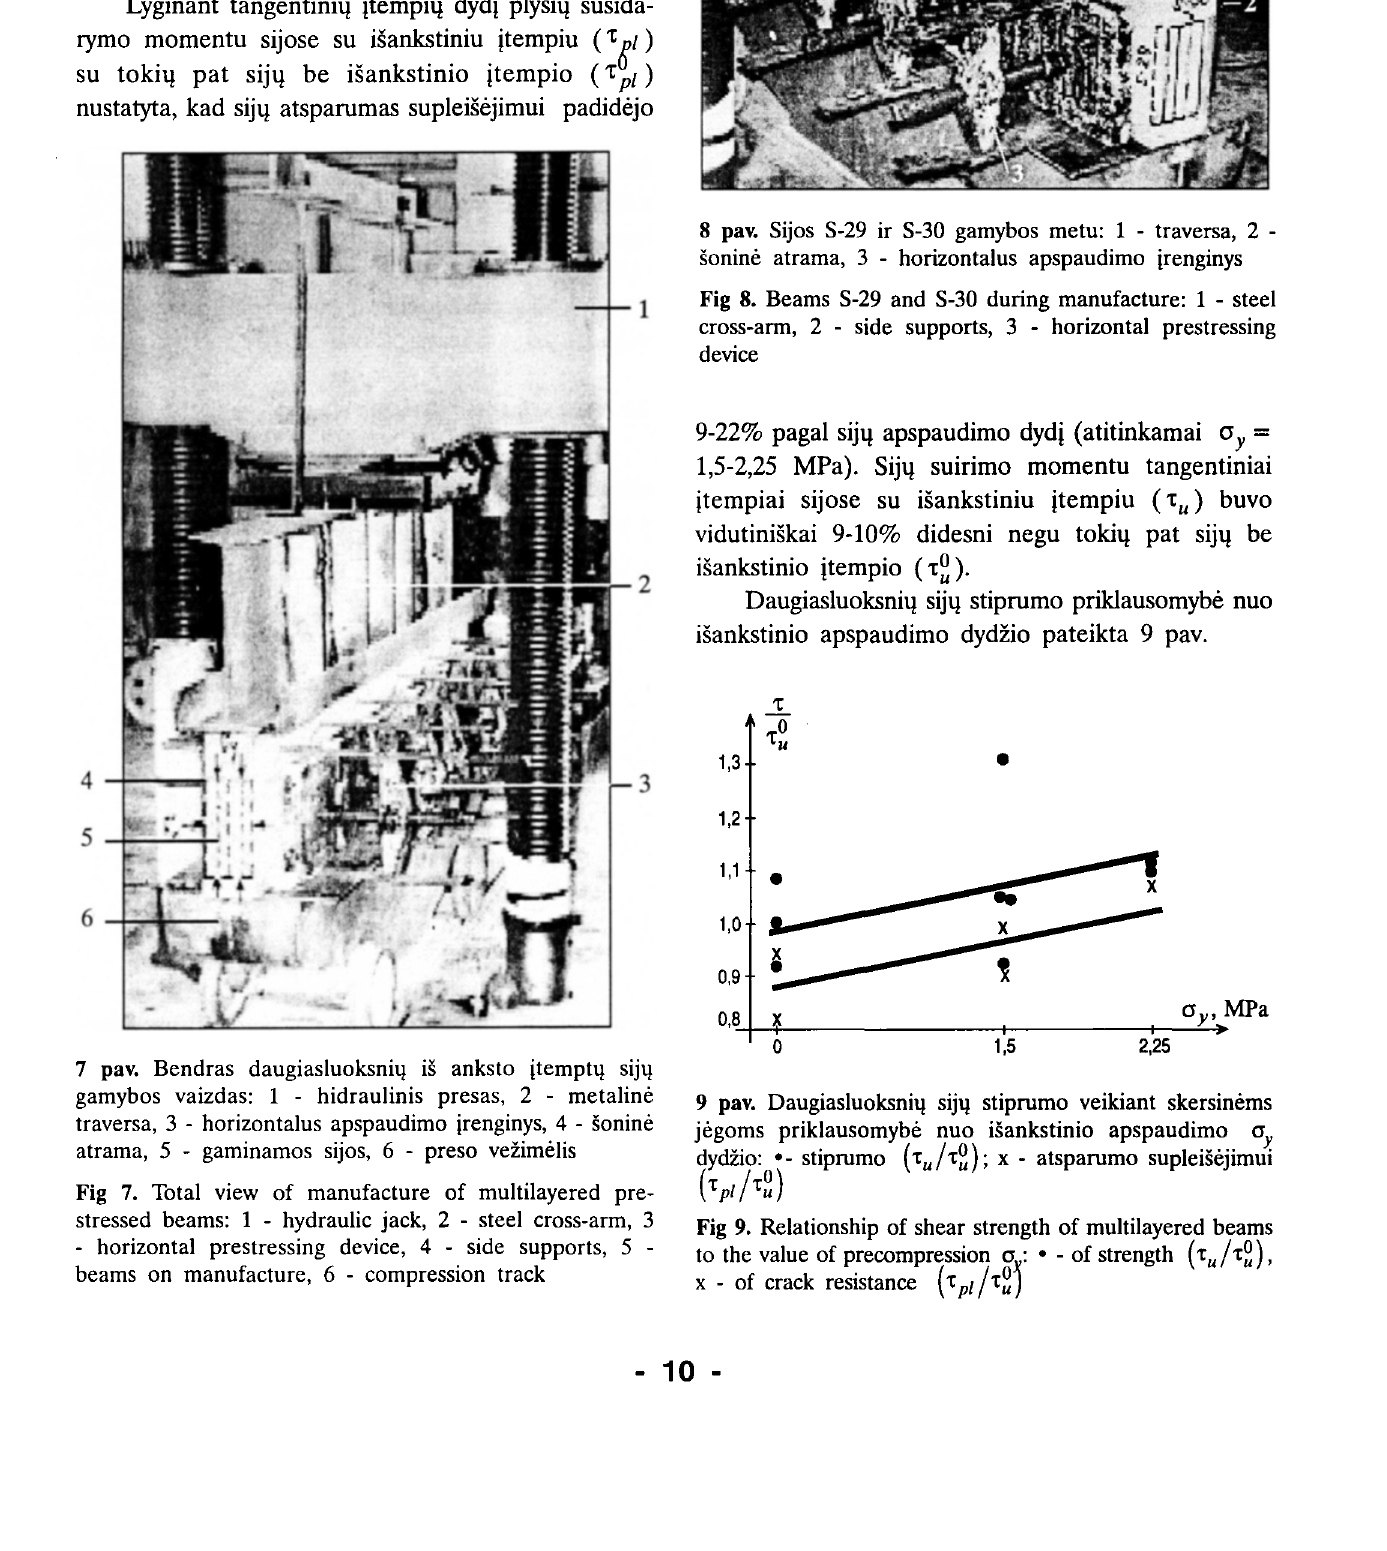
Fig 7. Total view of manufacture of multilayered pre stressed beams: 1 - hydraulic jack, 2 - steel cross-arm, 3 - horizontal prestressing device, 4 - side supports, 5 - beams on manufacture, 6 - compression track